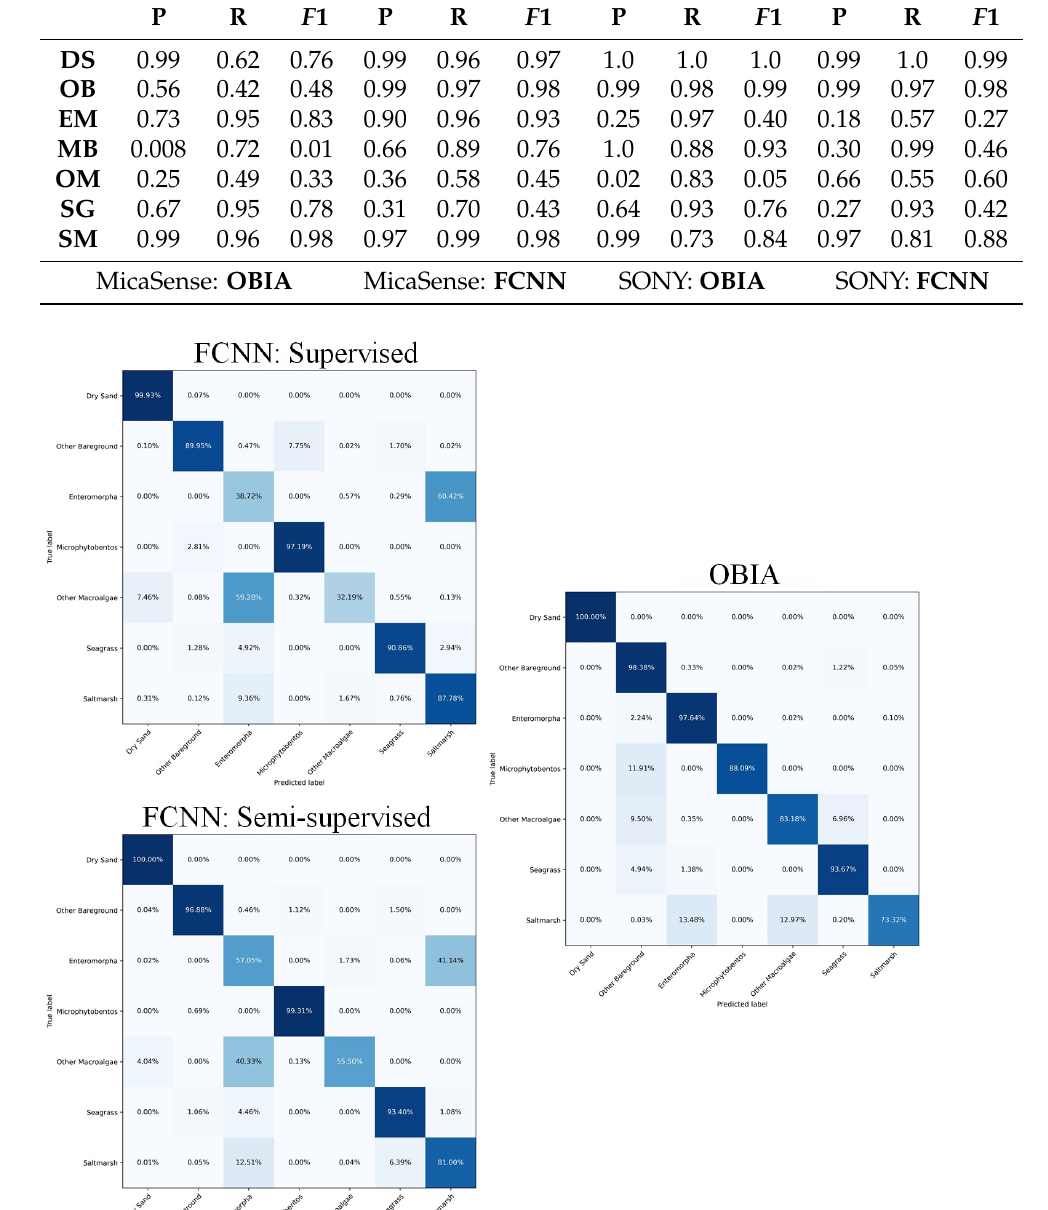
Table 1. Precision , recall and F 1 scores for both algorithms on both cameras. DS—Dry Sand; OB—Other